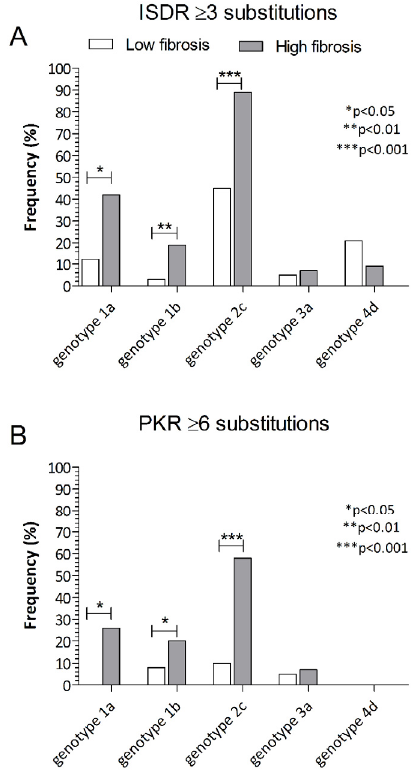
Figure 1. ( A ) Correlation between advanced fibrosis and ≥ 3 substitutions in interferon sensitivity-determining region (ISDR) according to genotype. ( B ) Correlation between advanced fibrosis and ≥ 6 substitutions in protein kinase R-binding domain (PKR-bd) according to genotype.